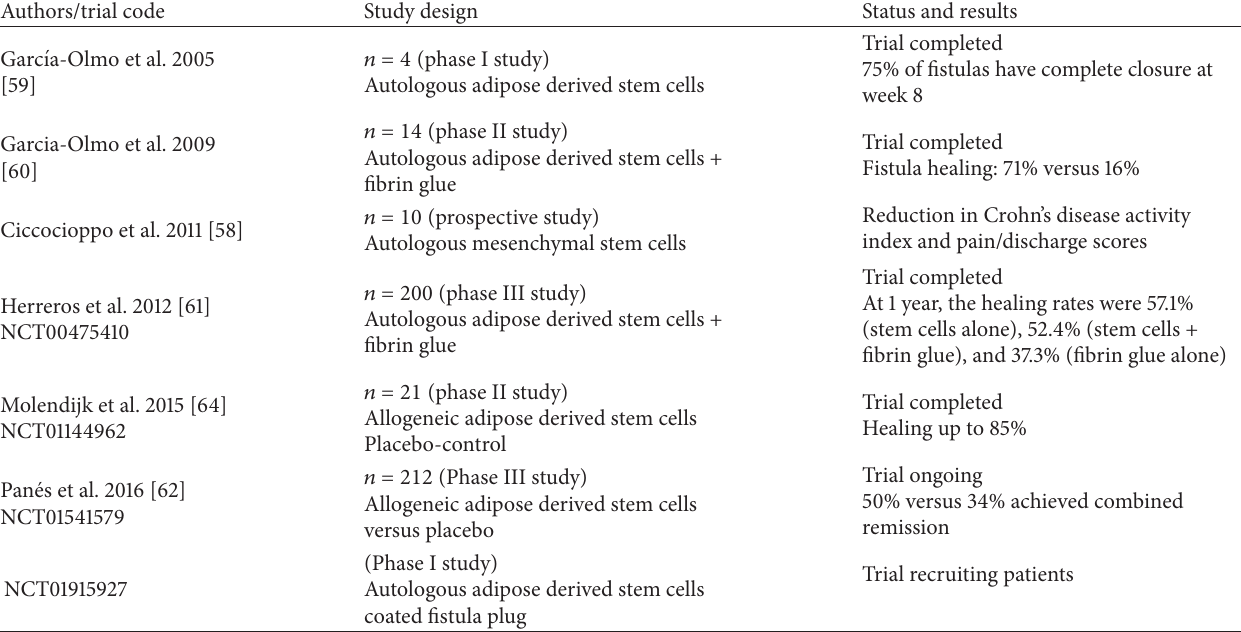
Table 2: Published and ongoing clinical trials using MSCs for the treatment of Crohn’s perianal